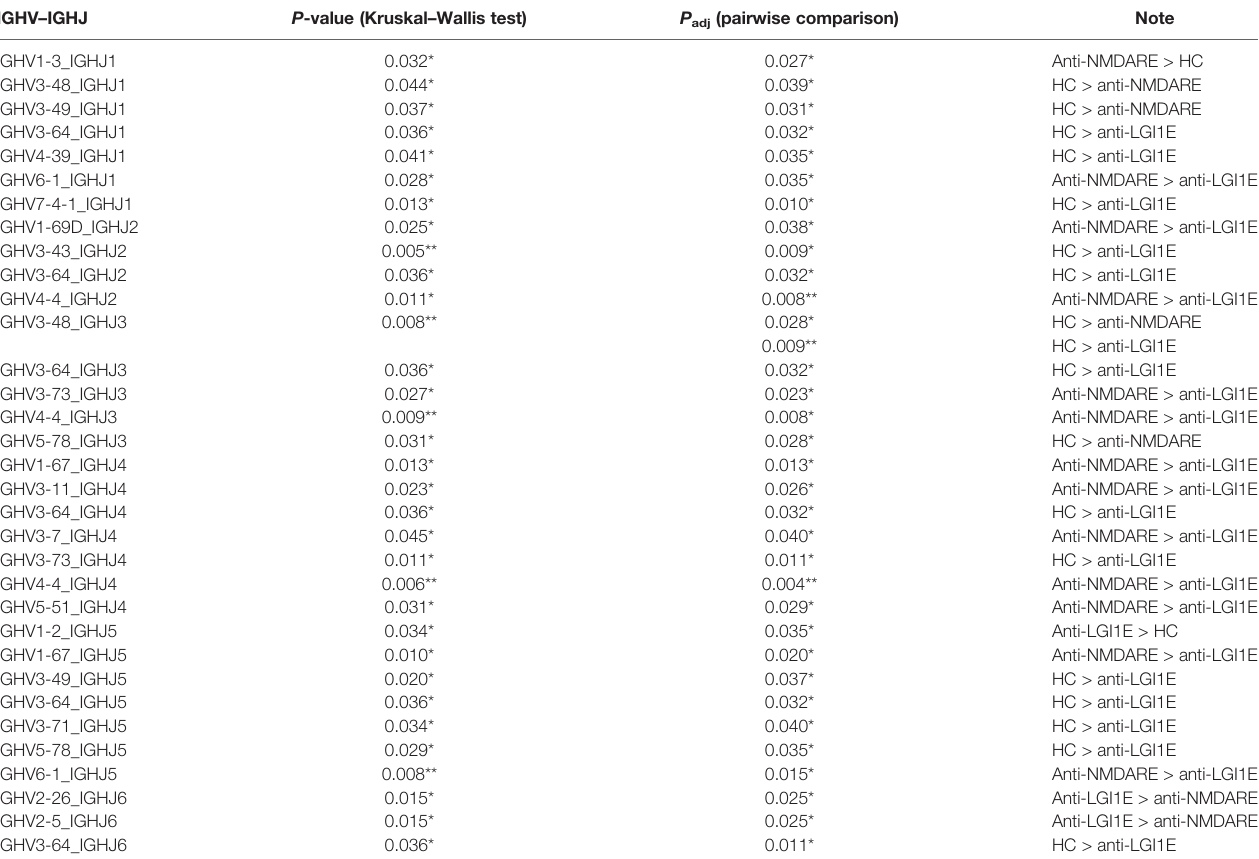
TABLE 3 | Summary of IGHV – IGHJ gene combinations with signi fi cant difference among the anti-NMDARE, anti-LGI1E, and HC groups. IGHV – IGHJ P -value (Kruskal – Wallis